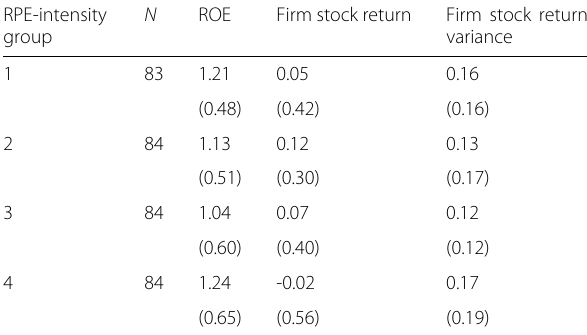
Table 6 RPE pay practices and bank-level characteristics RPE-intensity group